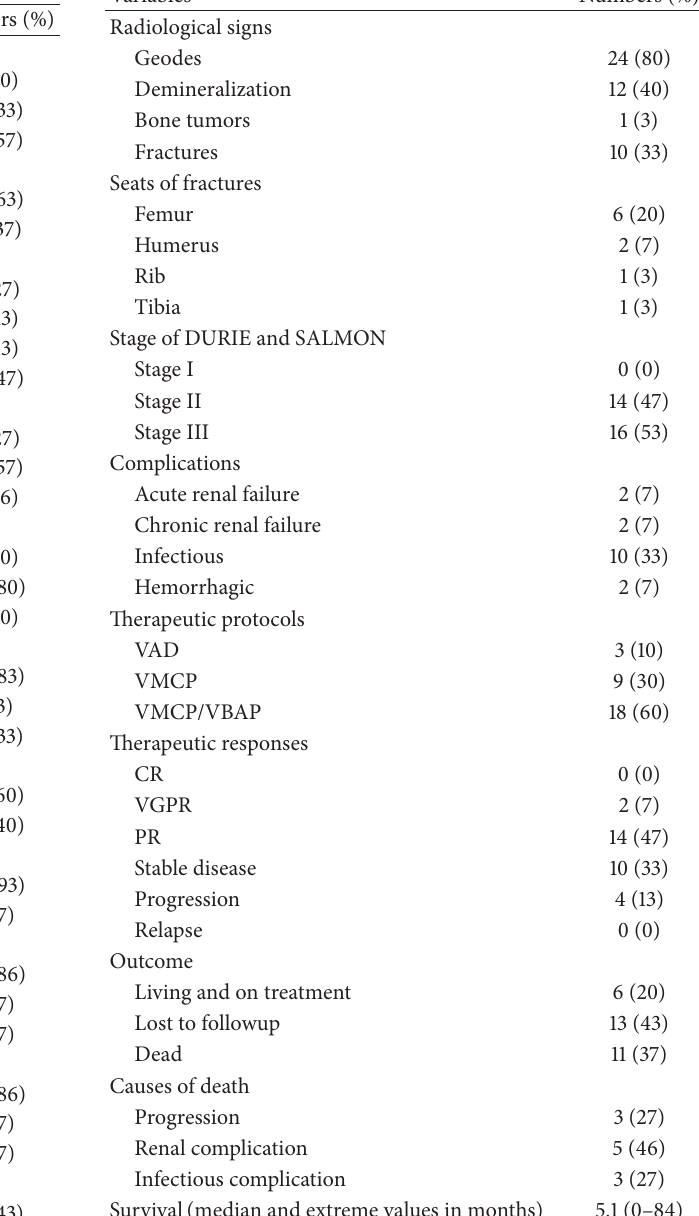
Table 1: Epidemiological, clinical, and biological features of patients.